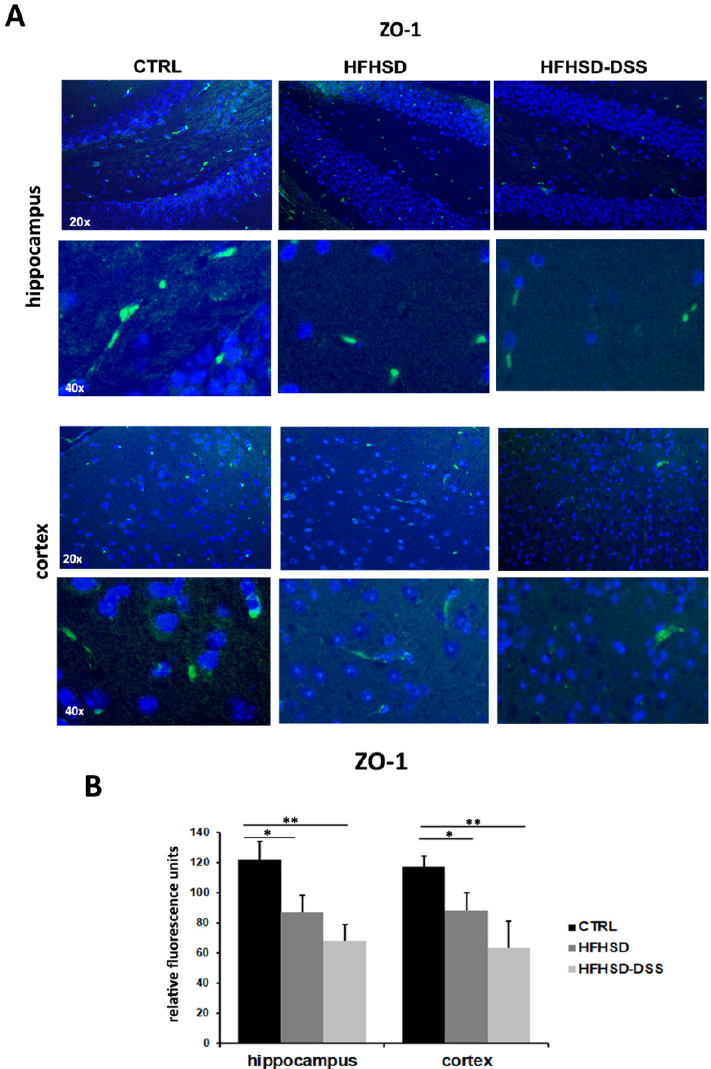
Figure 6. ( A ) Representative images of ZO-1 immunofluorescence in the hippocampus and cortex of both treated groups and control. ( B ) Quantitative analysis of immunofluorescence detection of ZO-1 in the hippocampus and cortex of both treated groups compared to controls; each value is presented as the mean ± SD for seven mice. Statistical significance: * p < 0.05; ** p < 0.01.